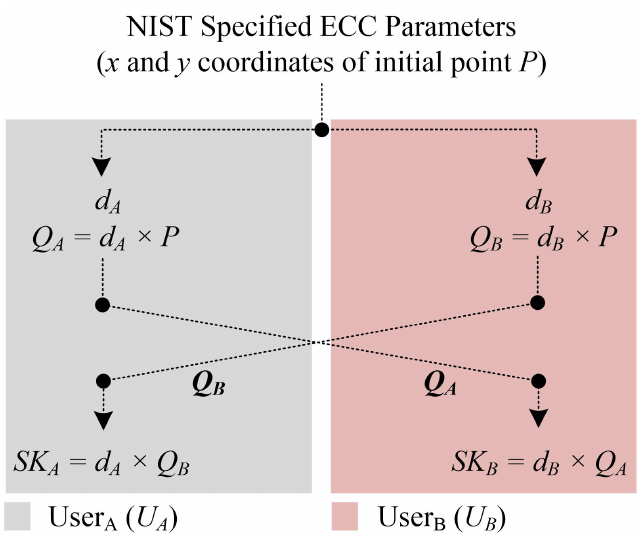
Figure 2. ECDH protocol for shared key generation or key agreement.